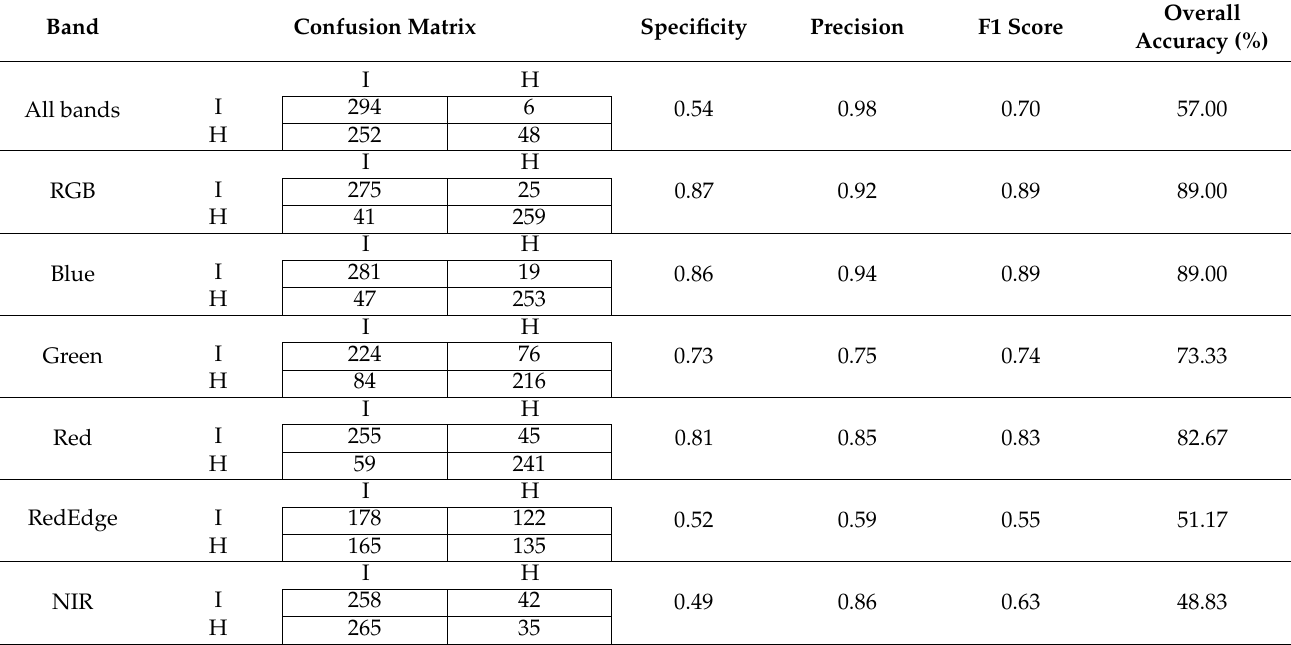
Figure 7. Boxplots comparing the reflectance of healthy and infected pixels from each multispectral band for the whole data set (n = 1000) used to train and validate the Support Vector Machine. Table 4. Confusion matrix and related statistics when a fine Gaussian Support Vector Machine (SVM) classifier is validated over to reflectance in the blue, green, red, red-edge, and NIR bands to classify 300 healthy (H) and 300 infected pixels (I) from cucumber images collected inside a greenhouse with a Micasense© Red Edge